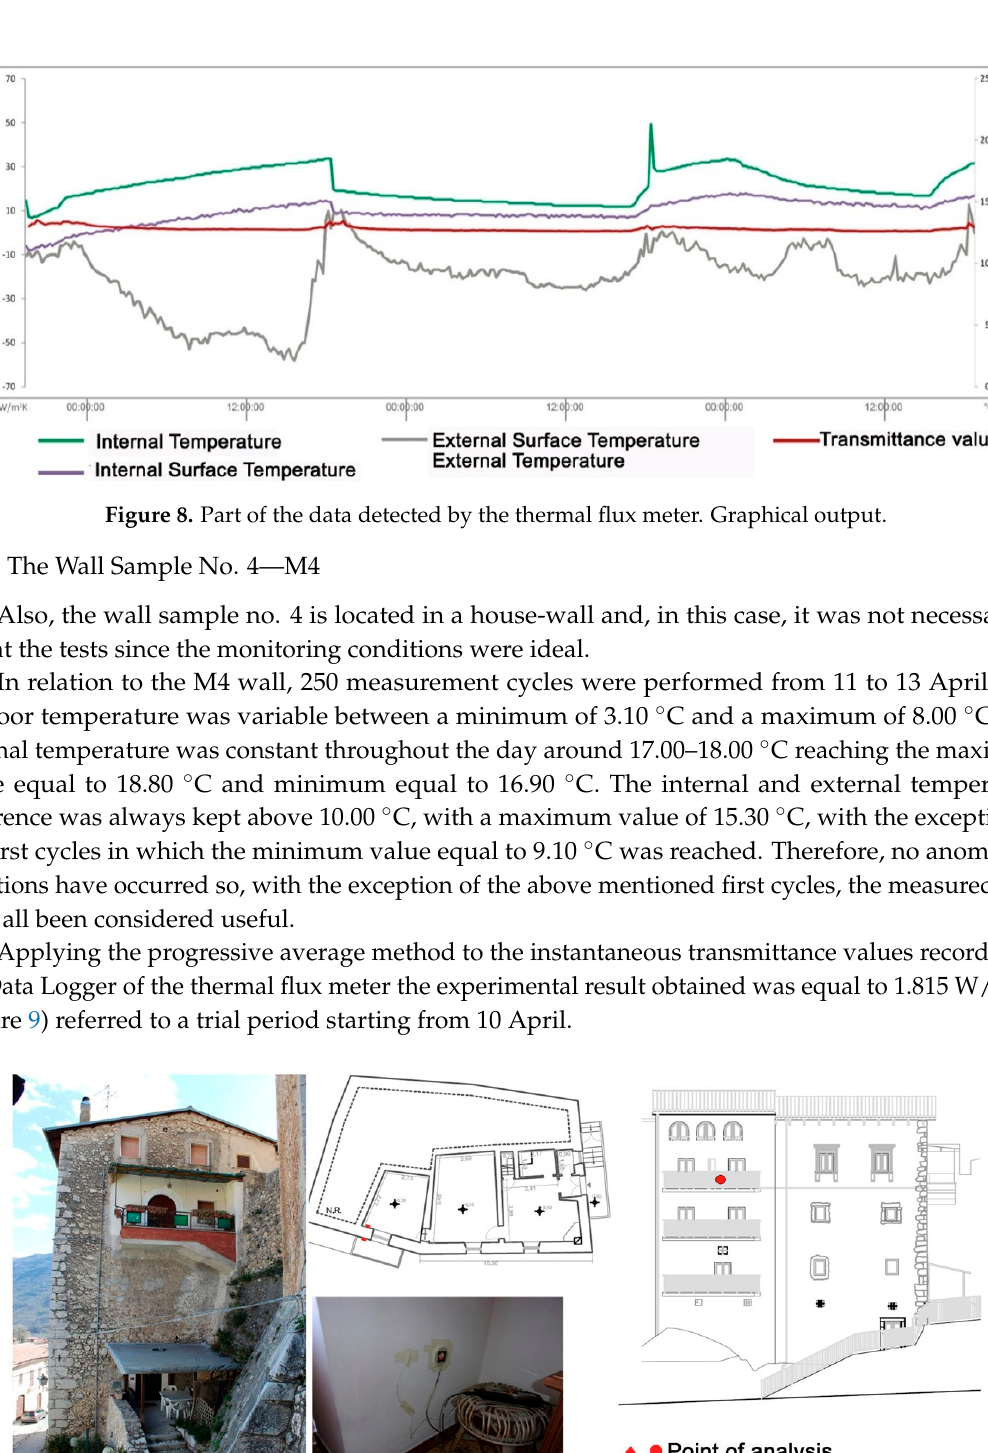
Figure 7. Point where the measurement was performed.